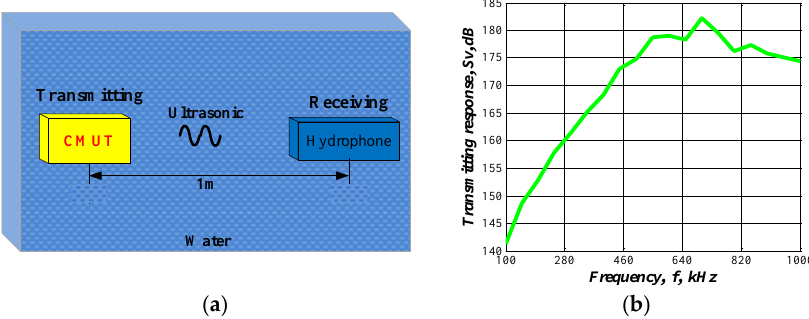
Figure 5. ( a ) Schematic diagram of the transmitting voltage response experiment; ( b ) Transmitting response.